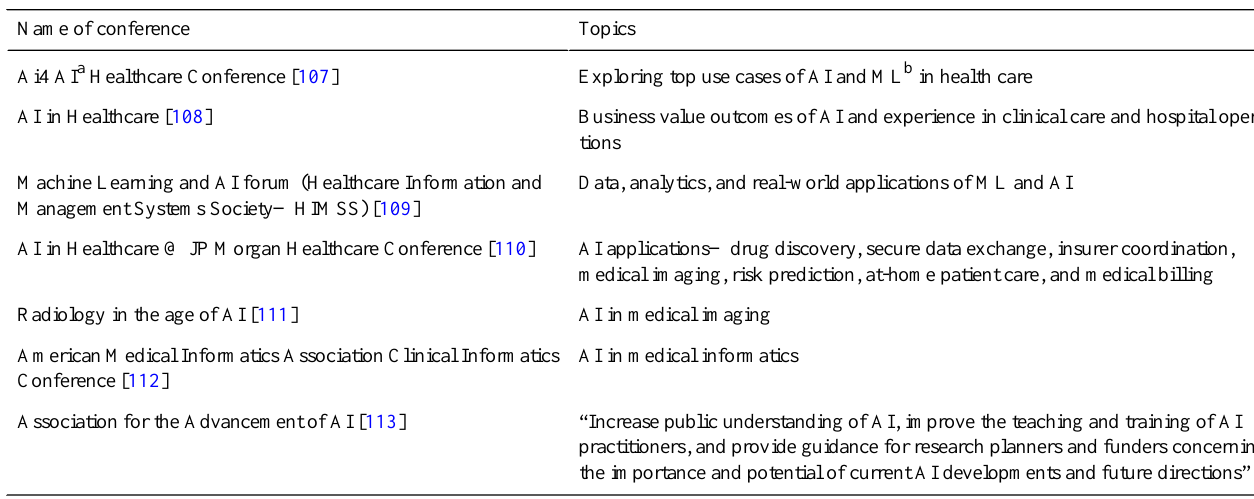
Table 4. List of artificial intelligence in health care